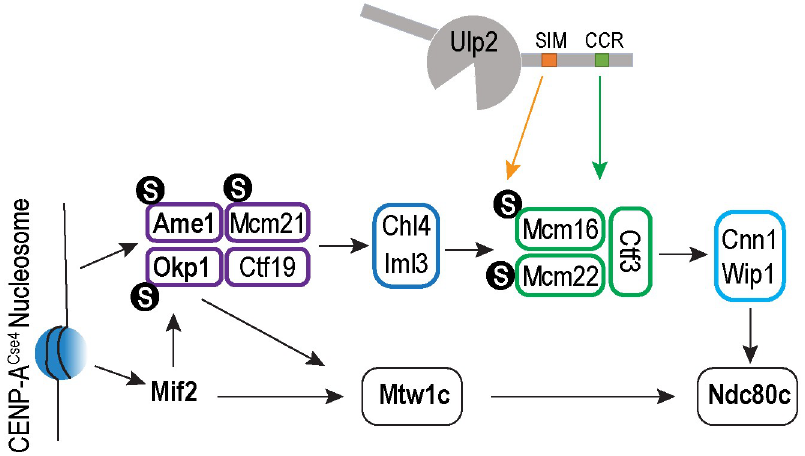
Fig 8. A model of how the Ulp2 protease is recruited to the kinetochore, via binding to the CMM complex and SUMO, to desumoylate the CCAN complex.